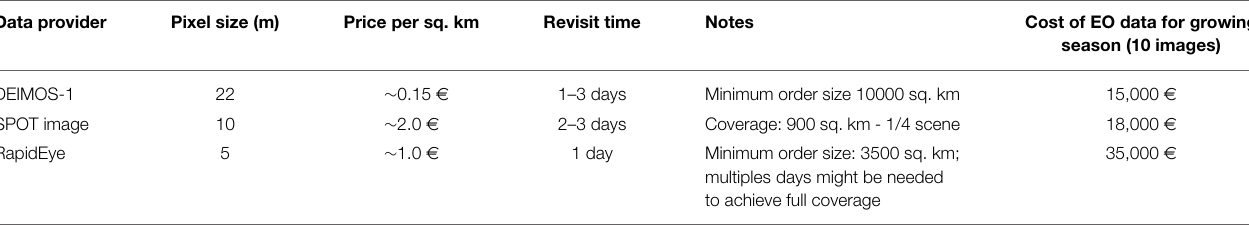
TABLE 2 | Summary of relevant satellite data provides and cost of